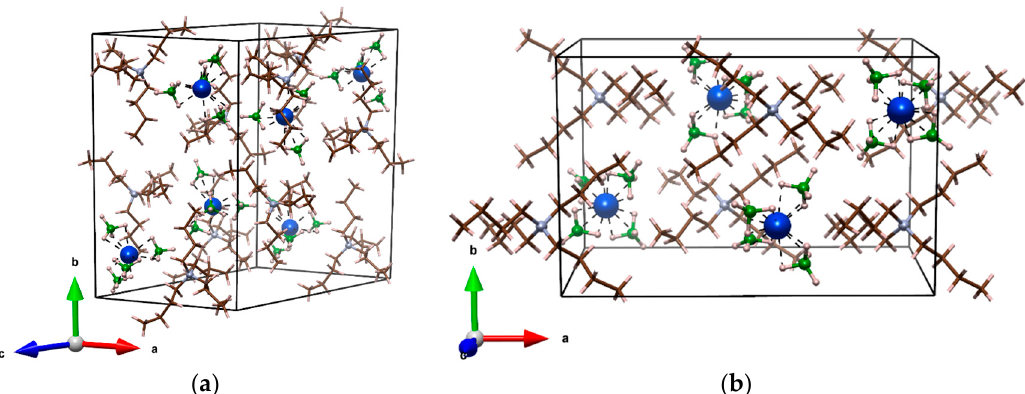
Figure 1. Crystal unit cells of: ( a ) α -[(n-C 4 H 9 ) 4 N] RE (BH 4 ) 4 (here RE = Ho); ( b ) β -[(n-C 4 H 9 ) 4 N] RE (BH 4 ) 4 (here RE = Ho). Blue color— RE atoms; green—B atoms; brown—C atoms; grey—N atoms; pink—H